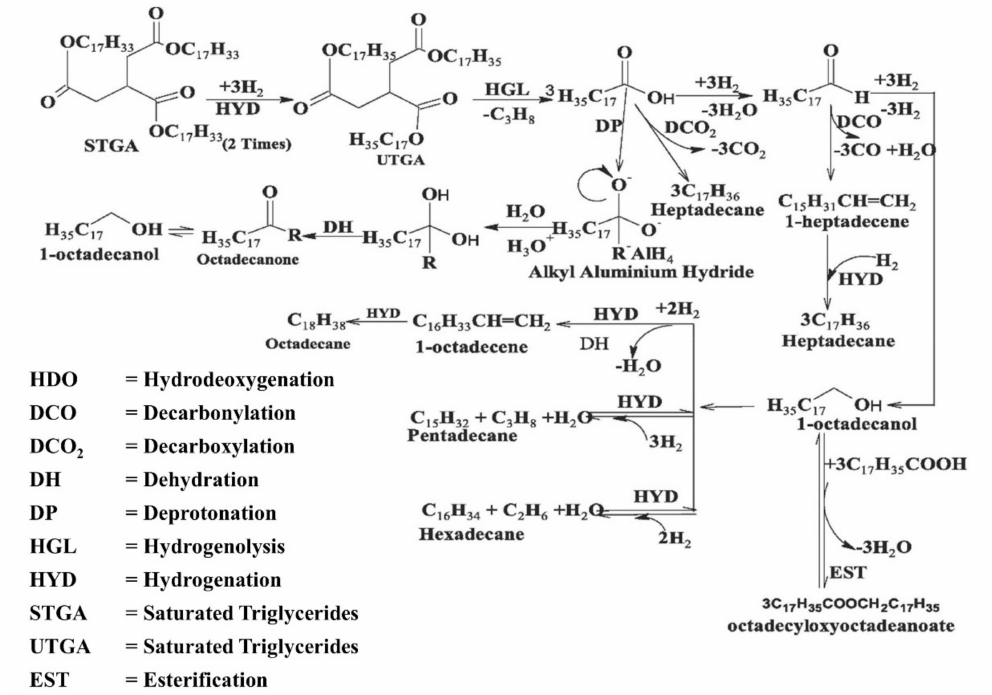
Figure 4. Mechanism of hydrodeoxygenation for renewable diesel production using sonochemically synthesized catalyst. Adapted with permission from ref. [30]. 2019